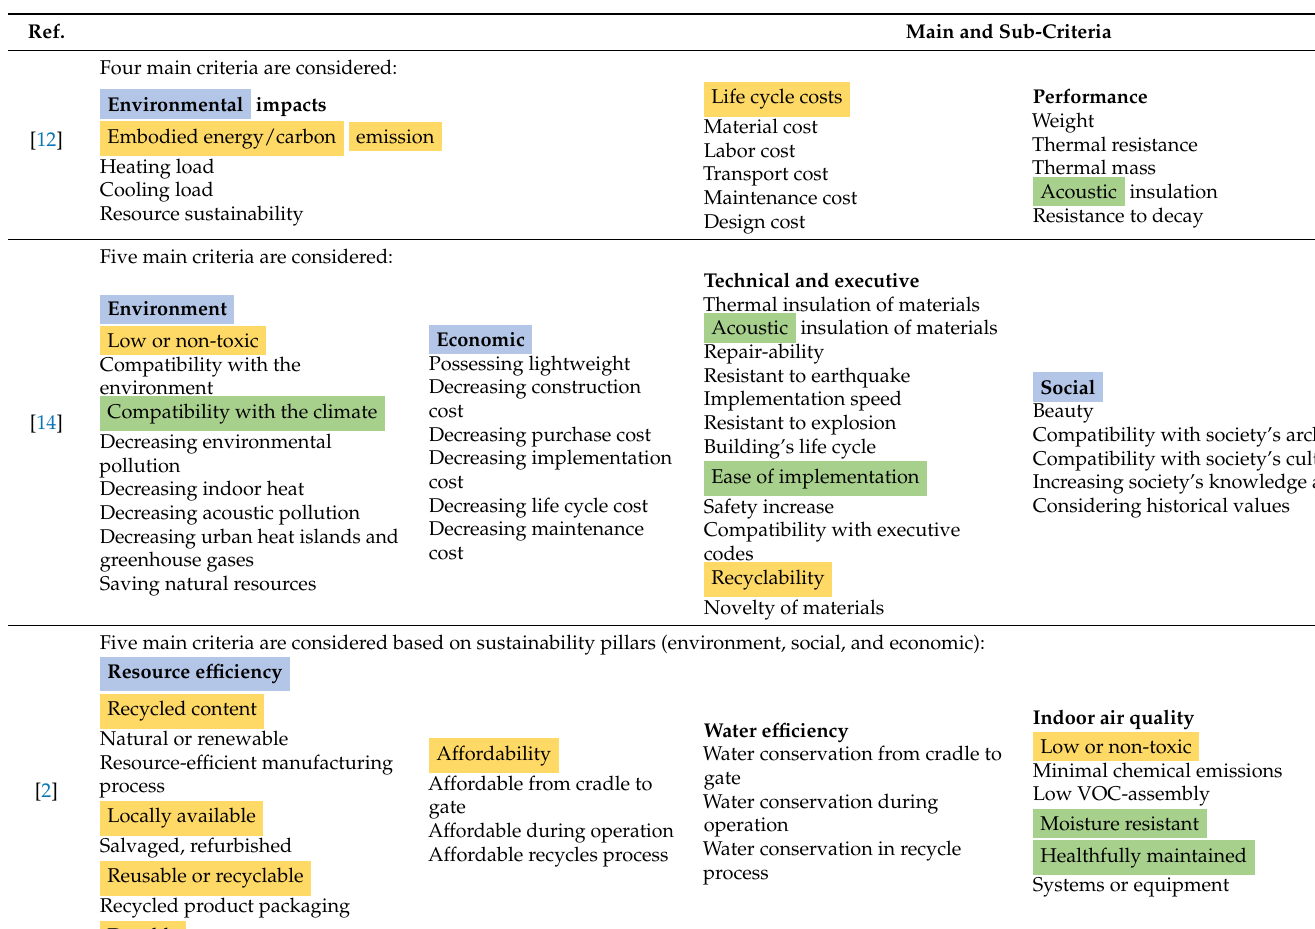
Table 1. Overview of multi-criteria assessment for selecting green building